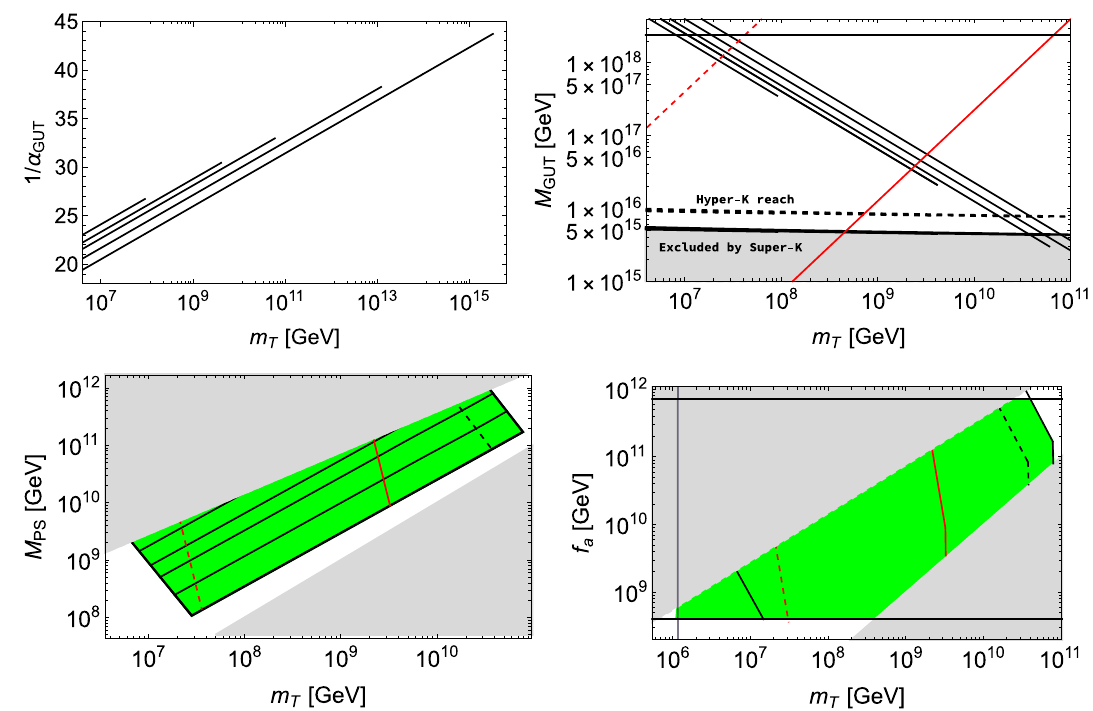
Fig. 3 Plots for f a < M PS and fixed m D = 2 TeV and m 45 = m T . Top-left (top-right) panel shows 1 /α GUT ( M GUT ) as a function of m T , where the solid black diagonal lines from left to right (right to left) correspond to m 126 / m T = 150 , 50 , 20, and 1, respectively. In the top- right panel, the top horizontal line corresponds to M GUT = M P . The gray shaded region is excluded by the lower bound on proton lifetime from the Super-K experiment, while the reach of the future Hyper- K experiment is depicted by overlapping horizontal dashed lines. The dashed and solid red diagonal lines display the lower bound on m T for m HC = 10 − 4 M GUT ( M GUT ) , respectively. The bottom left panel shows the allowed parameter region in ( m T , M PS ) plane. The solid black diagonal lines that run from bottom-left to top-right correspond